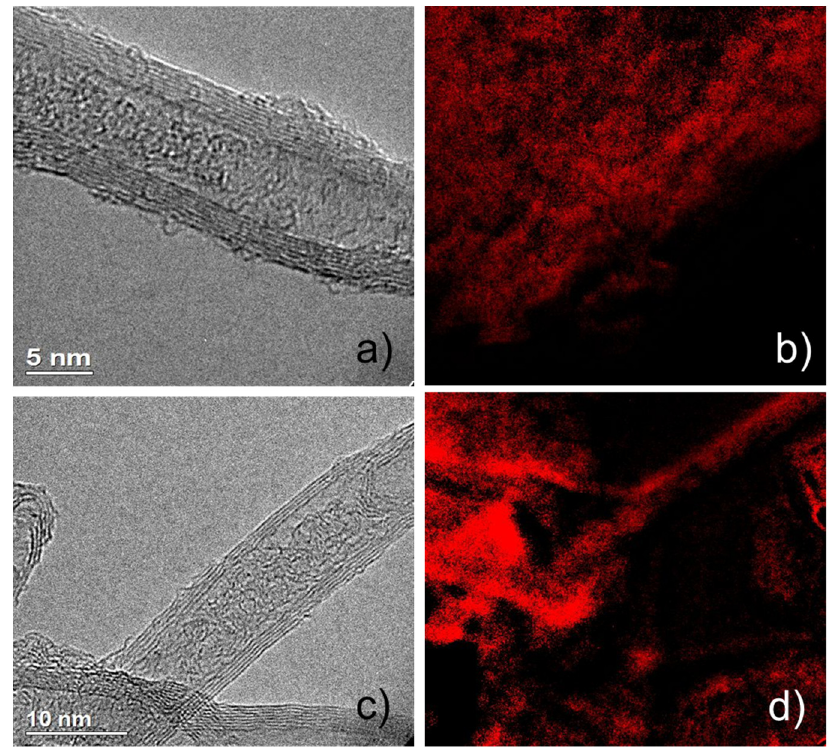
Figure 2. TEM and EDS images of ( a ) LA-MWCNT (Lewis acid-multi-wall carbon nanotube); ( b ) S mapping of LA-MWCNT; ( c ) spent LA-MWCNT; and ( d ) S mapping of spent LA-MWCNT.